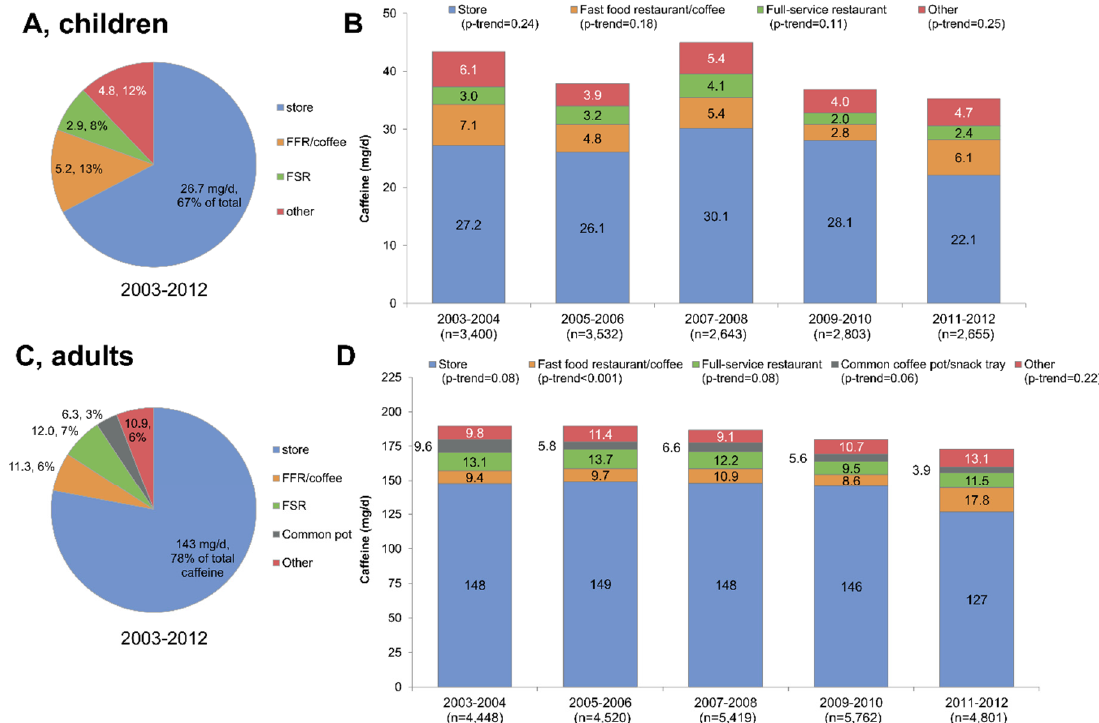
Figure 4. Trends in caffeine consumption by purchase location of origin, shown separately for children ( A , B ) and adults ( C , D ). Data are for NHANES 2003–2012. FFR stands for fast food restaurant; FSR stands for full ‐ service restaurant.